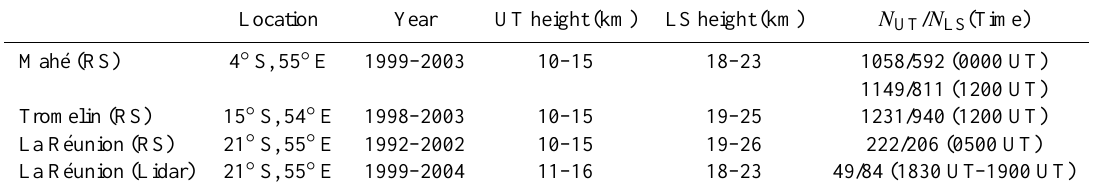
Table 1. Location of sites, time period, and height ranges used to derived gravity-wave energy density in the UT/LS above Mah´e, Tromelin and La R´eunion. N UT and N LS are numbers of analyzed high-quality vertical profiles respectively in the UT and LS. RS means